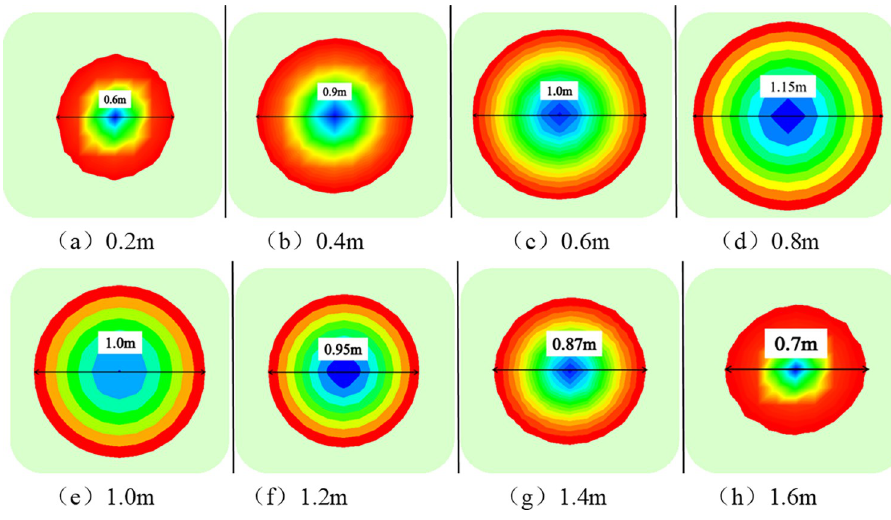
Fig 9. Compressive stress range diagram of different sections along the length of the bolt.